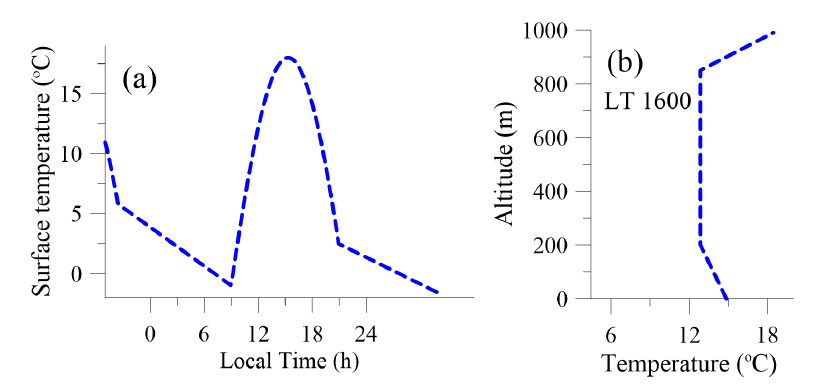
Figure 3. ( a ) Surface temperature time plot (data taken from [14]). ( b ) Initial temperature profile (assigned to 16:00 local